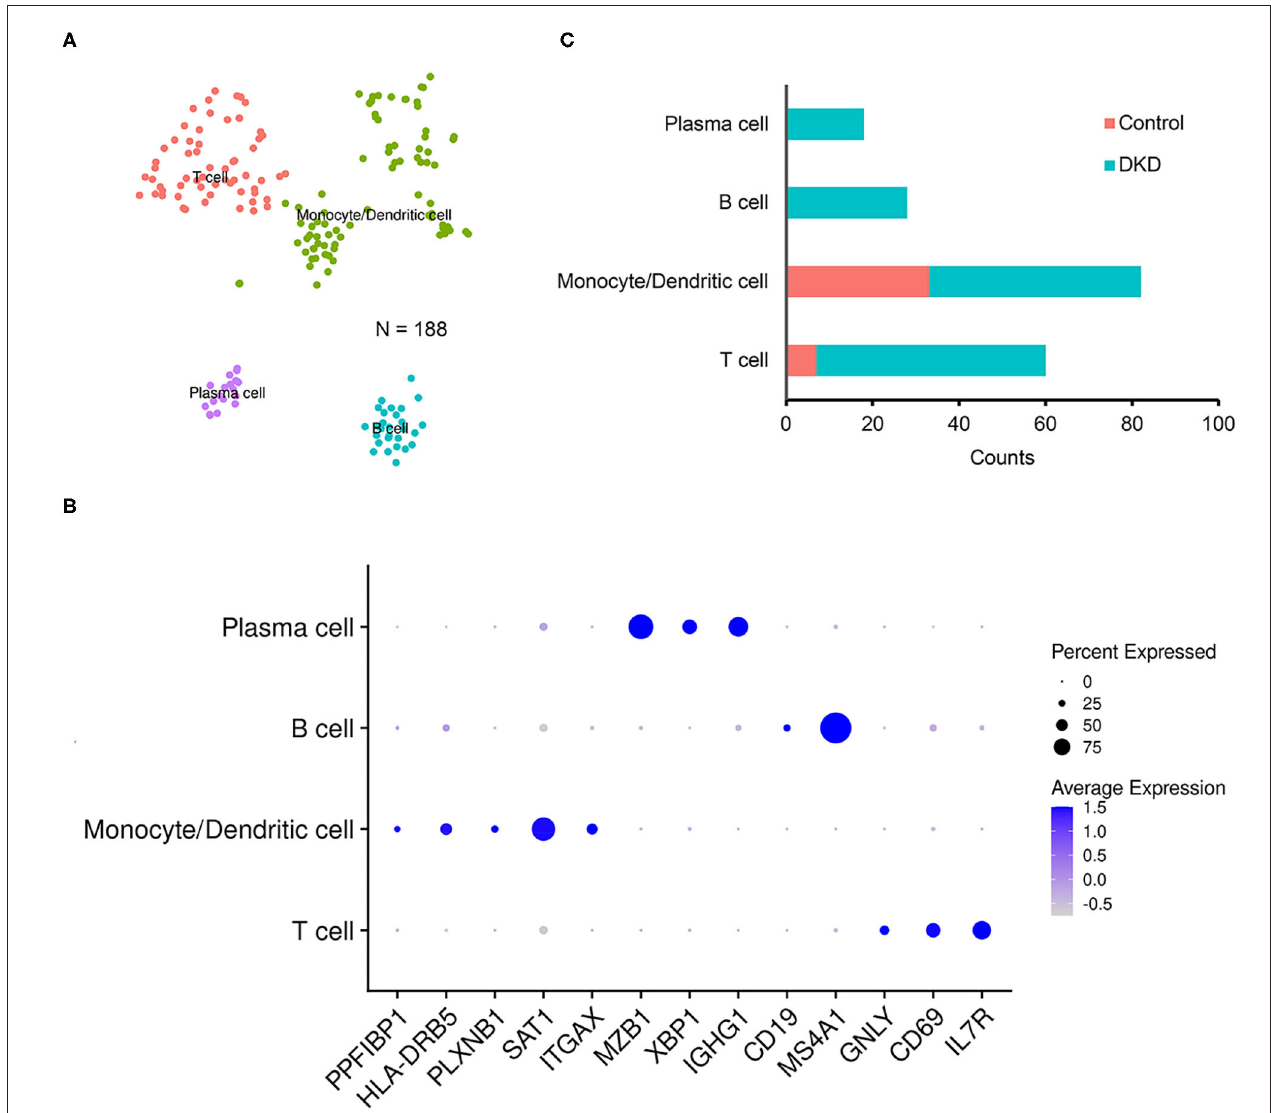
FIGURE 2 | Immune cells in non-diabetic and diabetic kidneys. We performed t-SNE analysis (A) , identified gene markers (B) , and determined the distributions (C) of the subclustered immune cells. T cells, monocytes and dendritic cells, B cells, and plasma cells were manually identified.